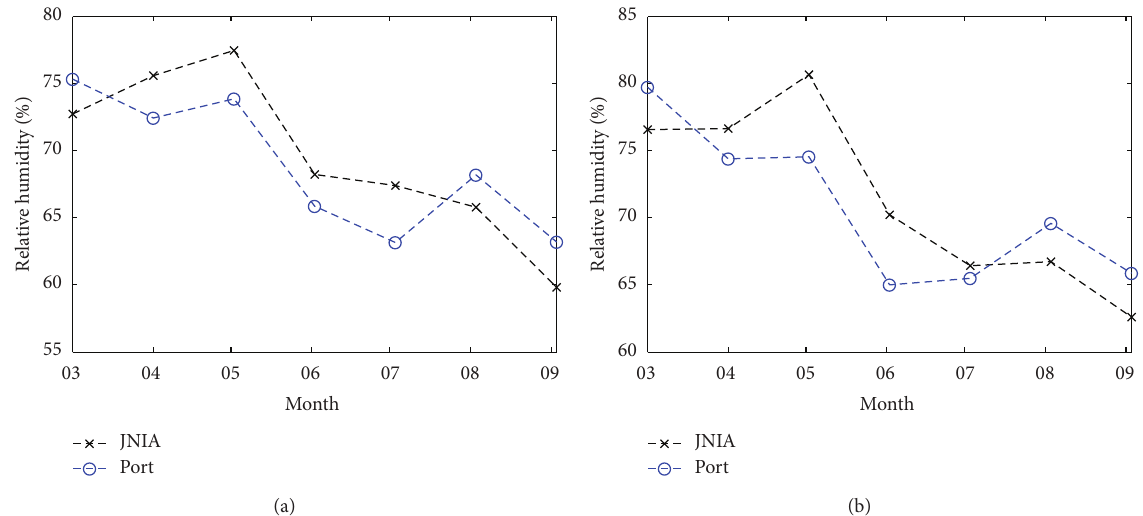
Figure 3: Mean monthly relative humidity at JNIA and Port (a) and its corresponding mean relative humidity at 15 LST (lowest relative humidity for the day) (b), for the period March–September 2005.